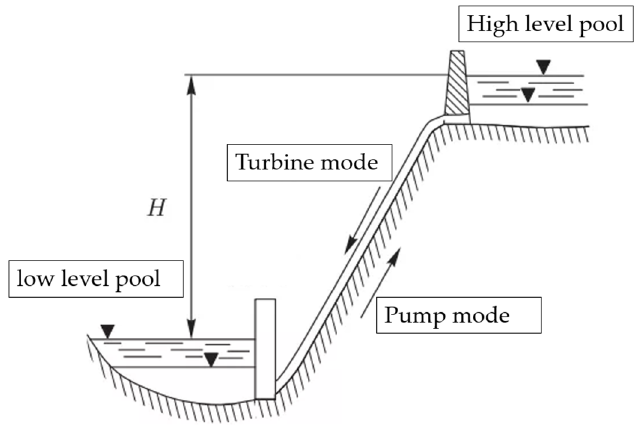
Figure 5. Pumped hydroelectric energy storage.